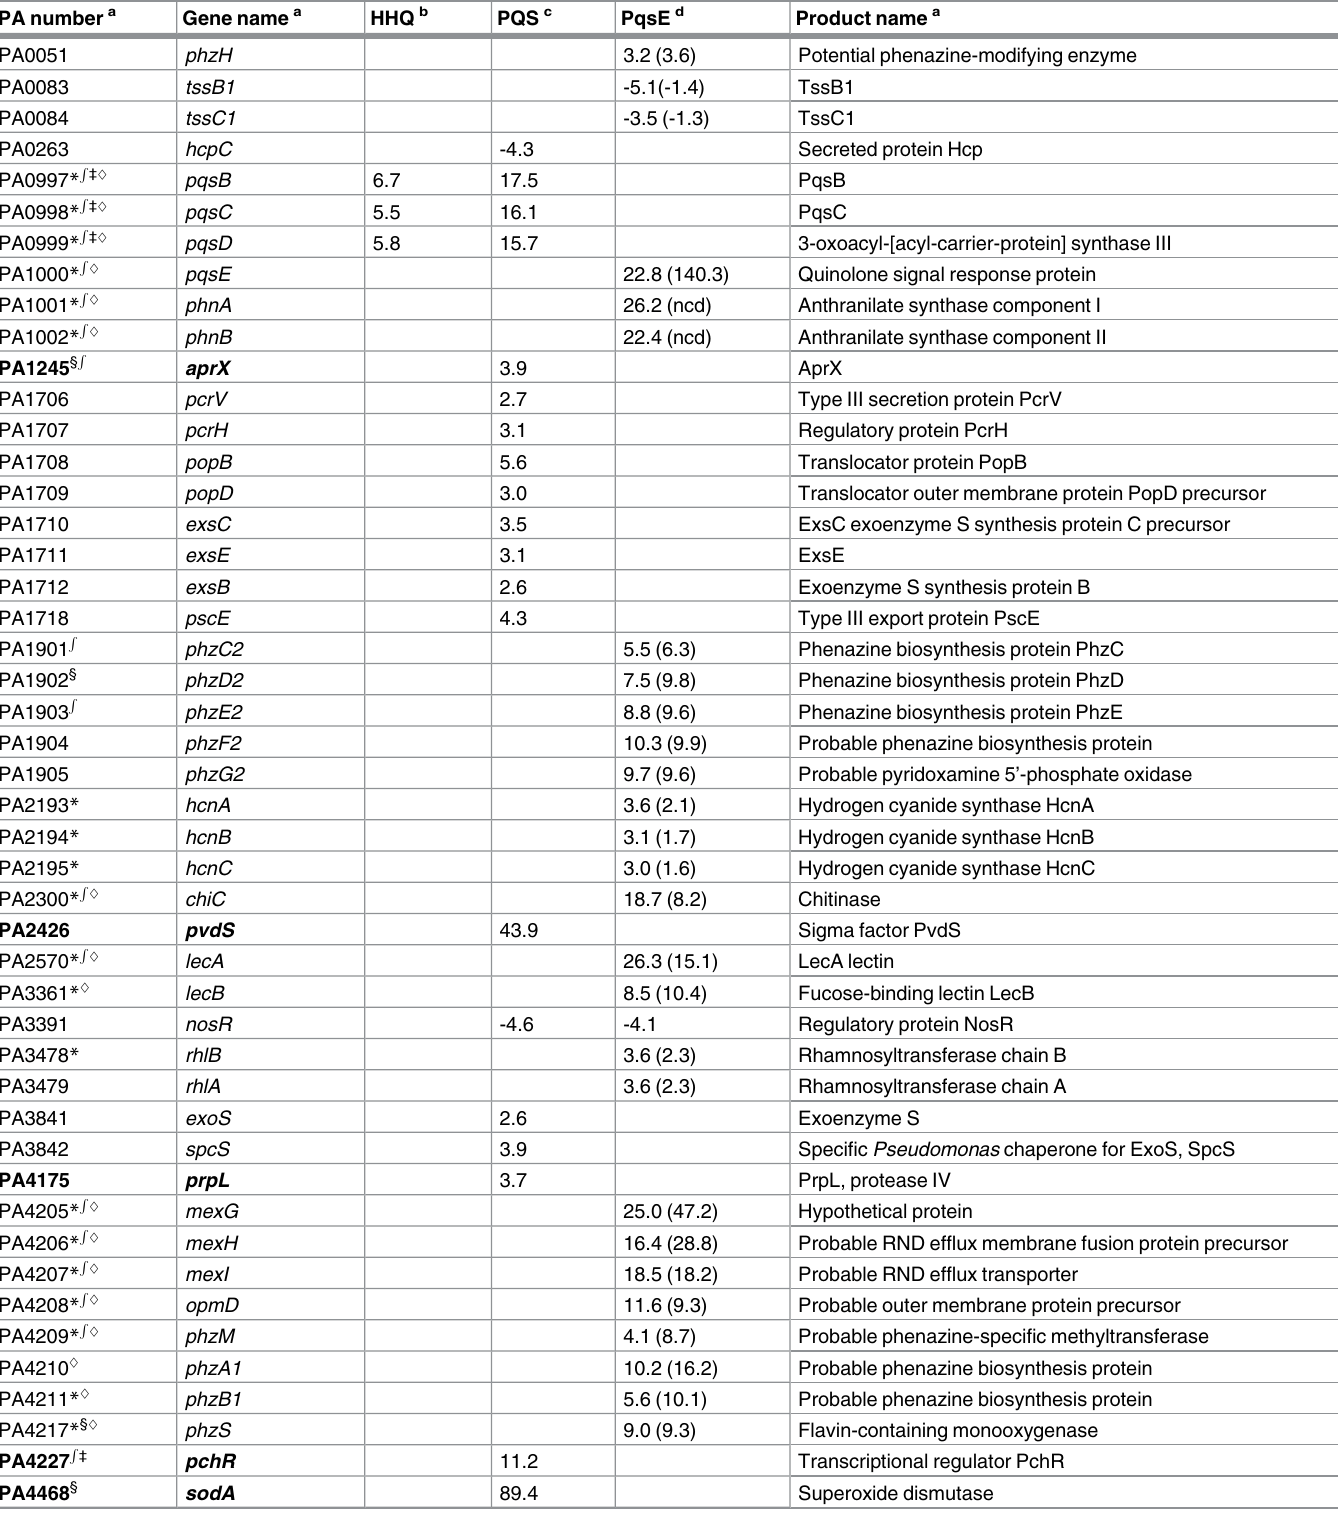
Table 1. Selected genes whose transcription is controlled by HHQ, PQS and/or